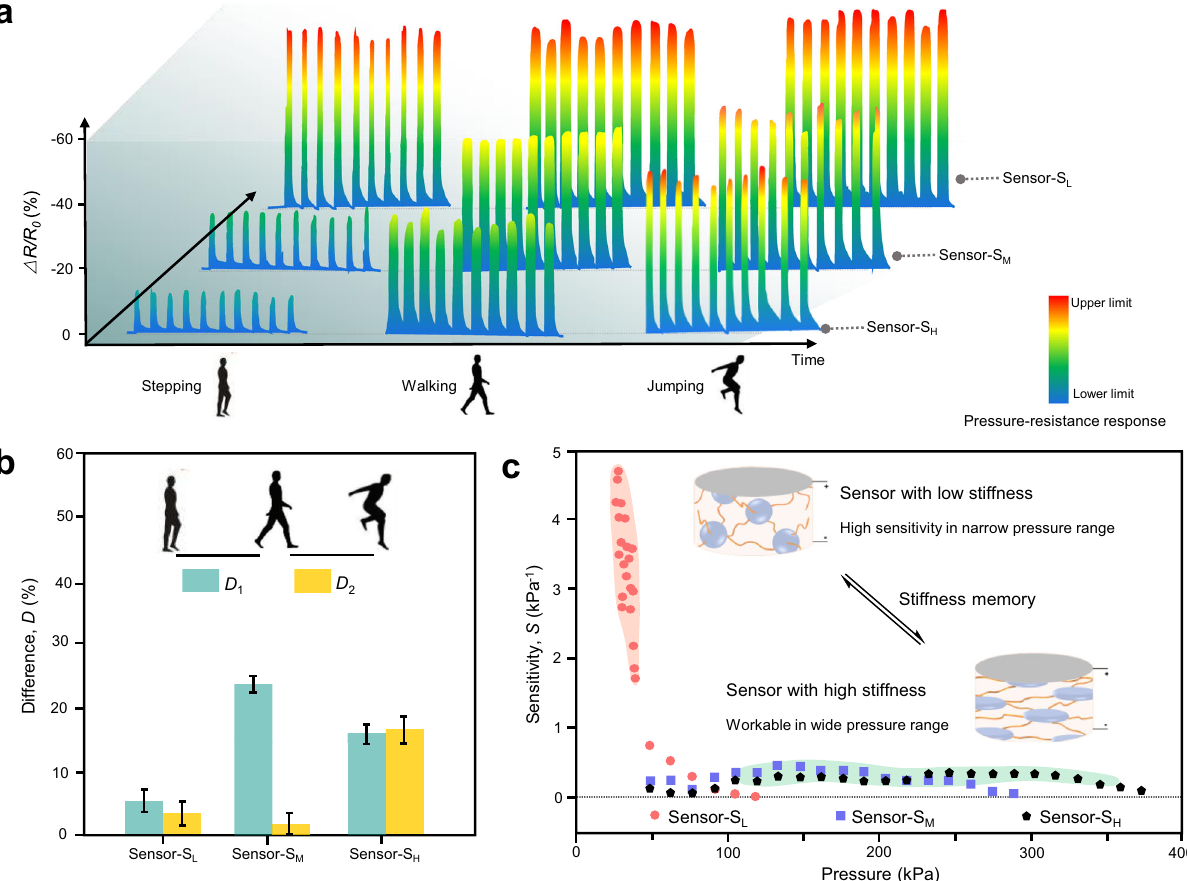
Fig. 5 Adaptive detection performance of the heterophasic ionogel sensors through stiffness memory. a Resistance signals of the ionogel sensors in detecting different human motions: stepping, walking, and jumping. Scale bar re fl ected the detection limit of the sensors and Δ R / R 0 value under different human motions. The upper limit (red) indicated that sensors lost detecting capability with increasing pressure. b Difference of resistance change ( D ) showing the capability of the sensors to distinguish the three motions of stepping, walking, and jumping. The error bars represent 1 SD ( n = 10). c Adaptive sensing could be realized with high sensitivity and wide pressure range through stiffness memory of the heterophasic ionogel pressure